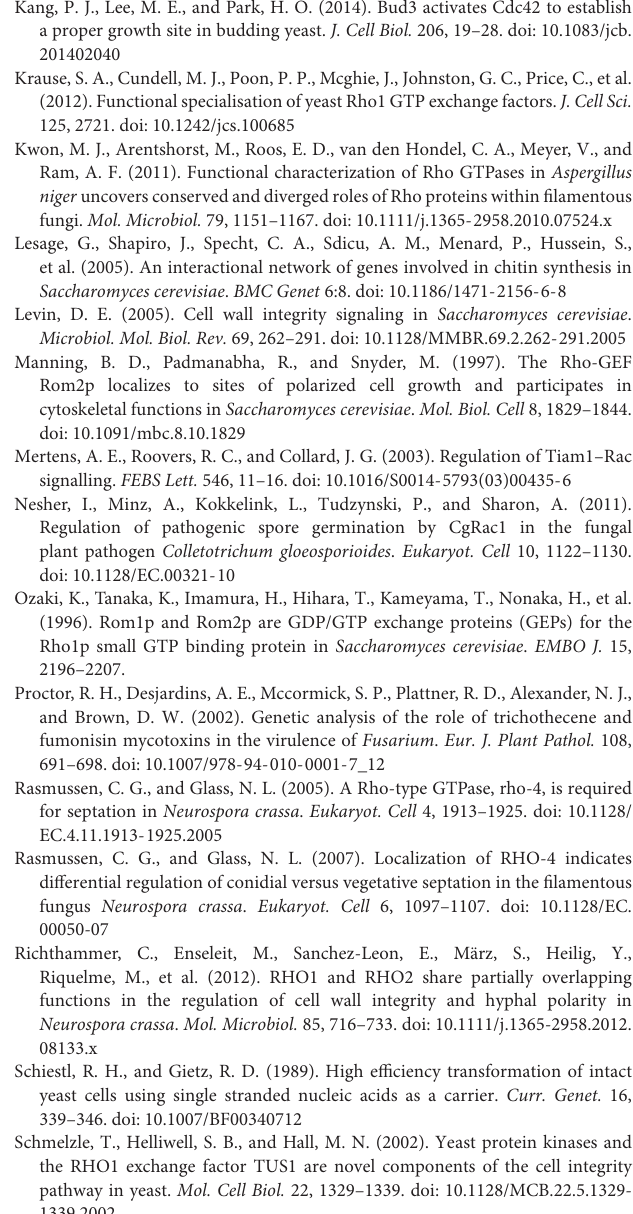
FIGURE S1 | Generation of the FgBUD3 deletion mutants. (A) FgBUD3 gene locus and gene replacement construct. The FgBUD3 and hph genes are marked with empty and black arrows, respectively. P, Pst I. (B) Genomic DNA isolated from mycelia of PH-1, and some transformants were subjected to PCR using primer pairs OF/OR and UAF/H853 marked in (A) . (C) Total RNA samples isolated from mycelia of PH-1, the FgBUD3 deletion mutant and the complemented strain were subjected to RT-PCR using the FgBUD3 gene-specific primer QF/QR ( Supplementary Table S1 ), ACTIN gene was amplified as positive control. (D) DNA gel blots of restriction enzymes marked in (A) digested genomic DNA were hybridized with probe marked in (A) . PH-1, wild-type strain; ( (cid:49) Fgbud3 , gene FgBUD3 deletion mutants; Fgbud3-com, complemented strain of FgBUD3 deletion mutant. TABLE S1 | PCR primers used in this